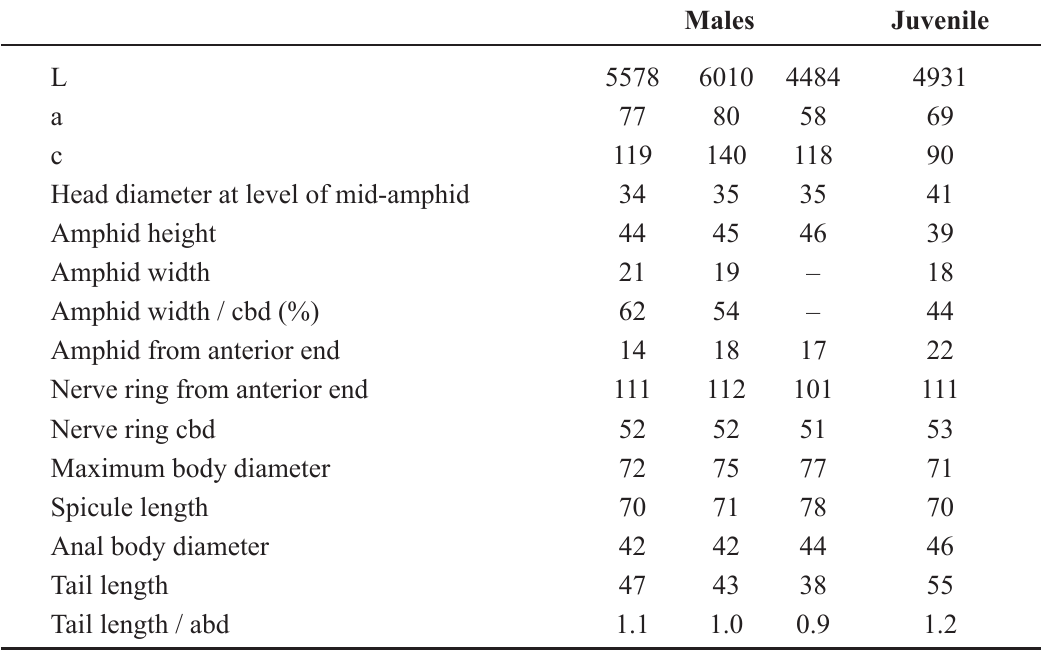
Table 1. Morphometrics ( µm) of specimens of Rhaptothyreus typicus from New Zealand’s southern Hikurangi margin. a = body length/maximum body diameter; abd = anal body diameter; c = body length / tail length; cbd = corresponding body diameter; L = body